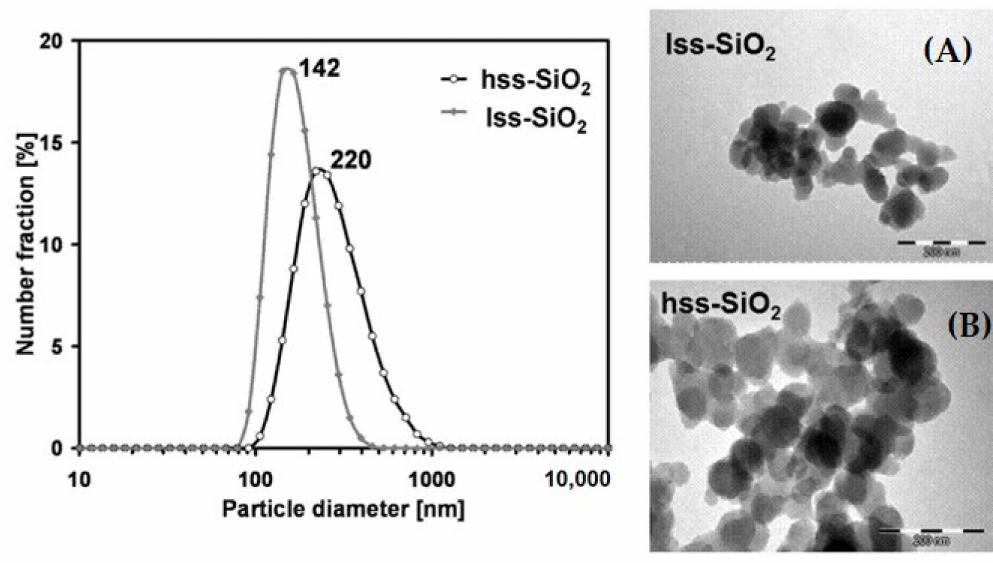
Figure 1. Particle size distribution of silica powders determined by DLS method (water, pH = 2) and TEM morphology of: lss-SiO 2 ( A ) and hss-SiO 2 ( B ) powders.